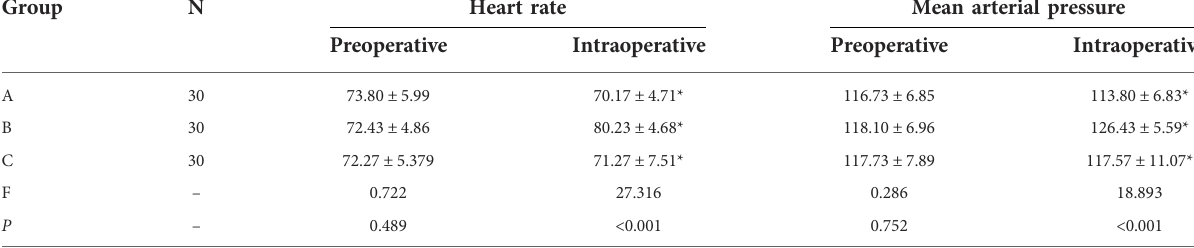
TABLE 4 Comparison of hemodynamic parameters among three groups (x±s). Group